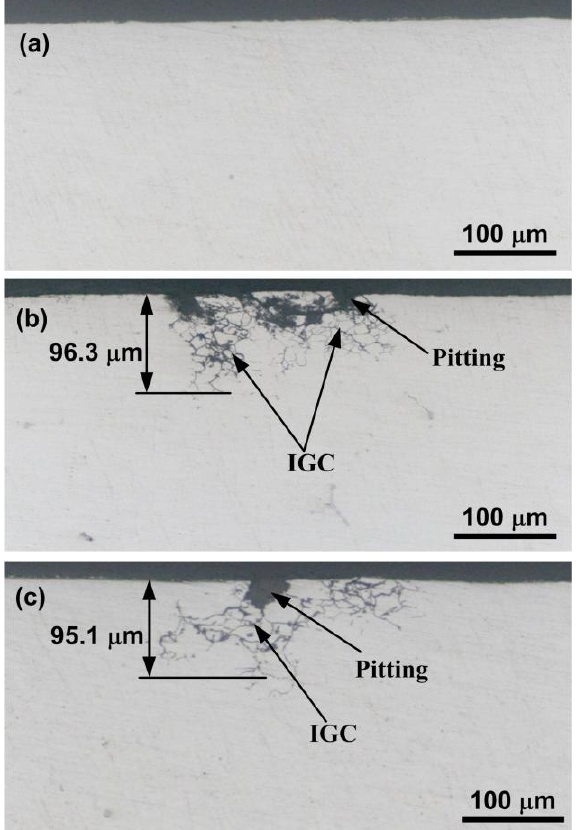
Figure 3. Cross-sectional morphologies of the 7085-T7452 aluminum alloy specimens: ( a ) as-received; ( b ) precorrosion; and ( c ) precorrosion + prefatigue.